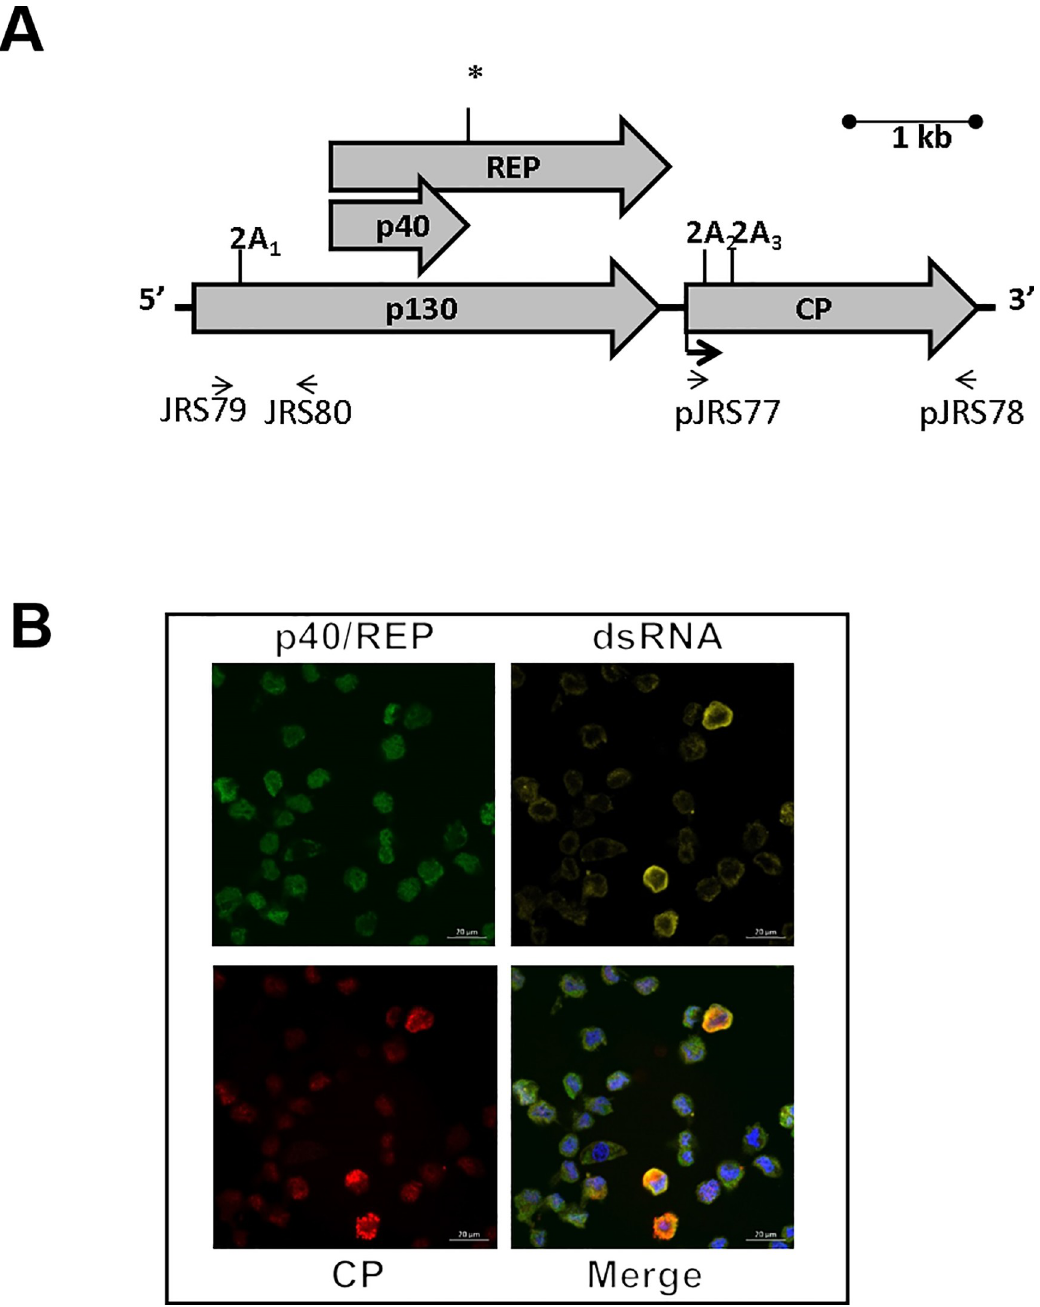
Fig 1. Providence virus in Helicoverpa zea MG8 cells. (a) Schematic diagram showing the genome organization of PrV. The three ORFs p130, REP (viral RdRp) and CP (viral capsid) are shown. The 2A-like processing sites (2A 1 , 2A 2 and 2A 3 ) are marked in p130 and CP. The ( � ) in REP indicates a readthrough stop codon resulting in the production of p40 (replication accessory protein) and REP from the same sequence. (b) Detection of p40/REP, dsRNA and the CP in insect H . zea MG8 cells. Cells were probed with mouse monoclonal anti-dsRNA and anti-mouse AF546 [8]. Viral replicase was stained with biotin-conjugated p40 and streptavidin AF488, while rabbit polyclonal anti-CP and anti-rabbit AF633 were used to detect PrV CP. All images represent 1 μ m optical slices taken using a Zeiss LSM780 laser scanning confocal microscope using a X63, 0.75 NA objective. Scale bar represents 20 μ m.